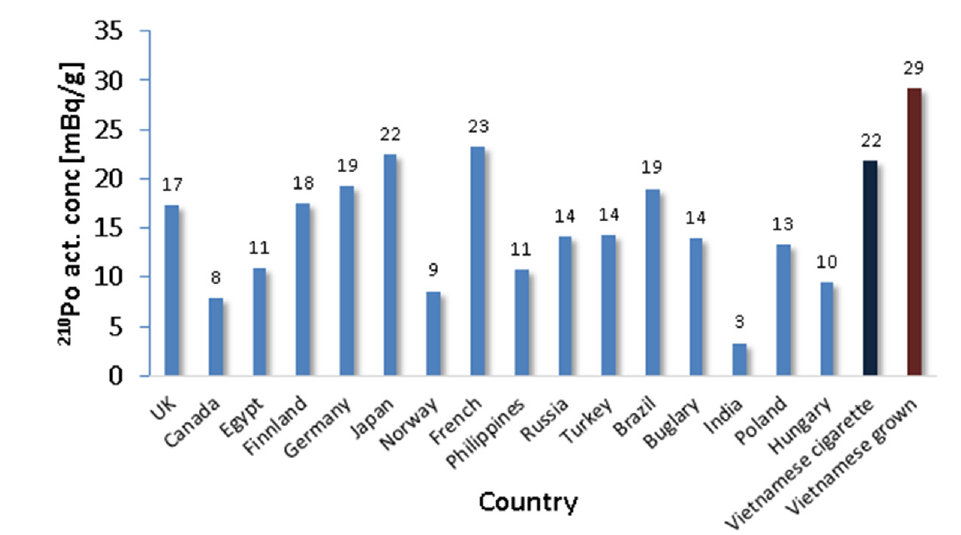
Figure 3. Average 210 Po activity concentration of cigarettes previously surveyed in foreign samples